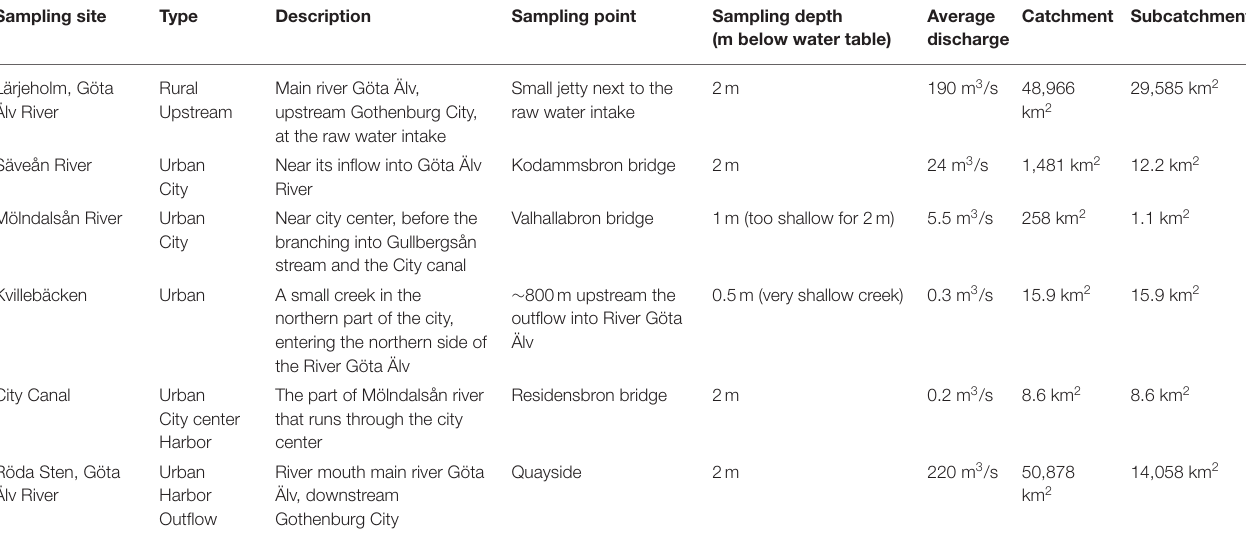
TABLE 1 | Description of the sampling sites. Sampling site Type Sampling point Sampling depth